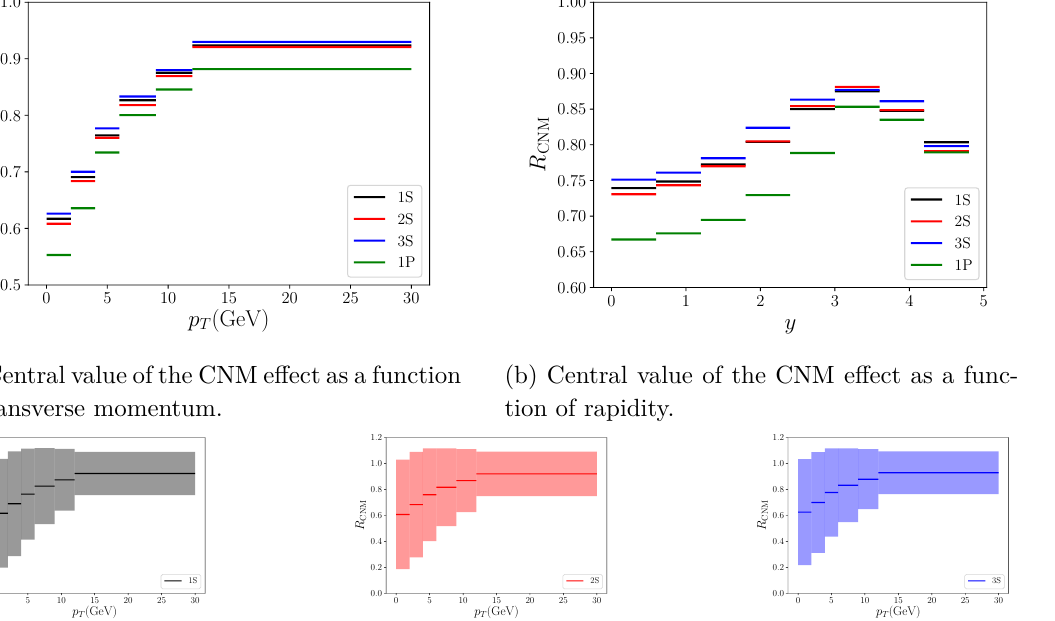
(d) Uncertainty band of R CNM ( p T ) for 2 S .